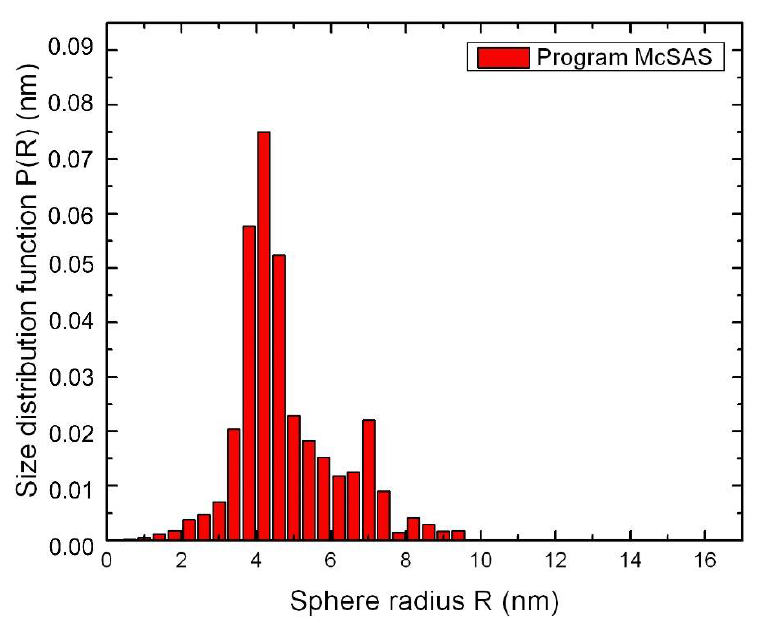
Figure 2. Size distribution function P(R) of nanoparticles Ag/Au (1:1) calculated by the Monte Carlo method.